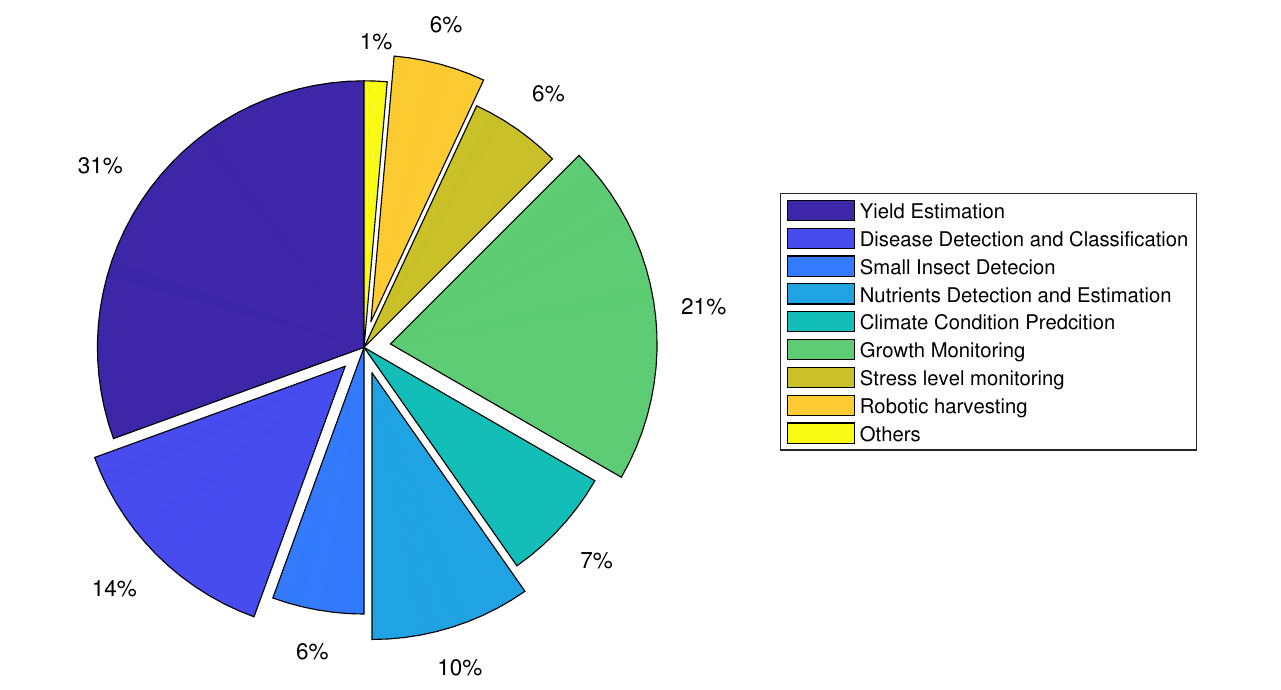
Figure 5. Application distribution of deep learning in controlled environment agriculture.